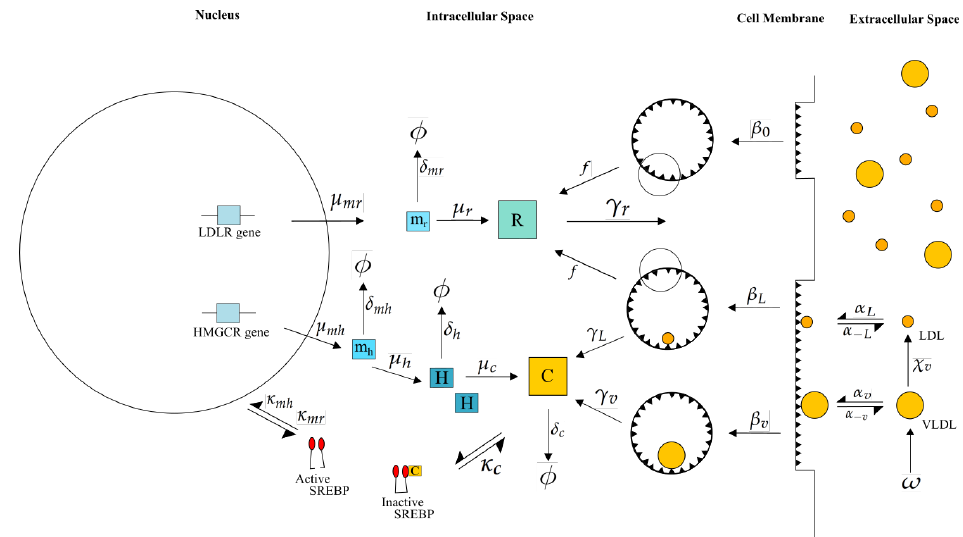
Figure 2. Our integrated model of cholesterol biosynthesis and lipoprotein endocytosis in a hepatocyte. Transcription of HMGCR and LDLR mRNA (at rates µ mh and µ mr , respectively) by SREBP-2 ( κ mh , κ mr ), leads to the synthesis of HMGCR ( µ h ), LDLR ( µ r ) and cholesterol ( µ c ), which negatively regulates SREBP-2 ( κ c ). In the extracellular space, VLDL delipidates to LDL ( χ v ) and each bind/unbind to LDLR on the cell surface ( α v , α − v , α L , α − L ). Finally VLDL and LDL occupied receptor pits are endocytosed ( β V , β L ) as well as empty ones ( β 0 ), cholesterol extracted from internalised lipoproteins ( γ v and γ L ) and receptors recycled in the intracellular space ( f , γ r ). Here m h represents HMGCR mRNA, m r LDLR mRNA, H HMGCR, R I receptors in the internal store, c intracellular cholesterol and φ degradation of the respective